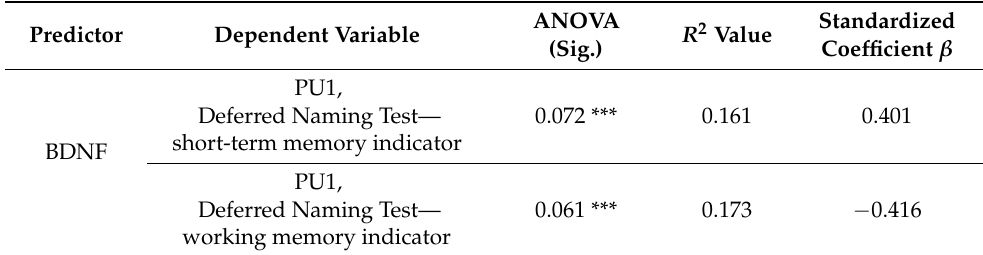
Table 2. Linear regression—second measurement, T 1